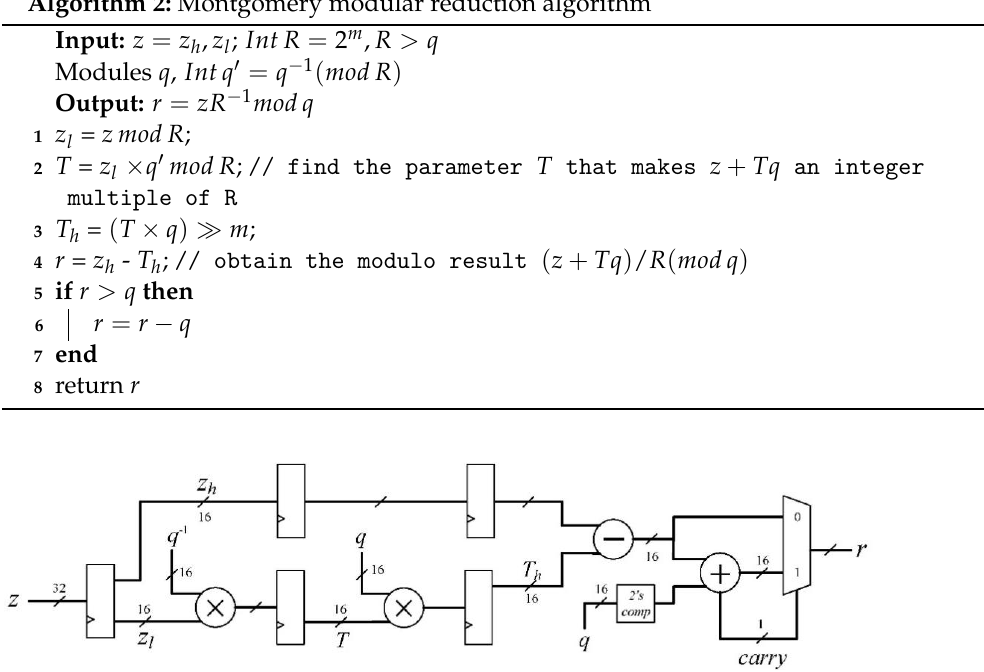
Algorithm 2: Montgomery modular reduction algorithm